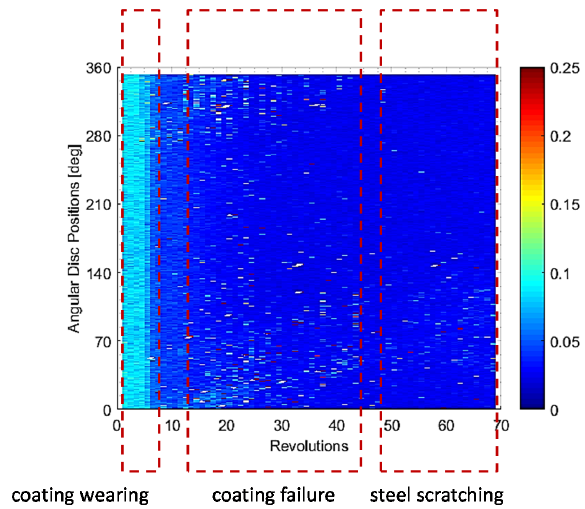
Figure 3. Average phosphor screen intensity as a function of time and disc position.